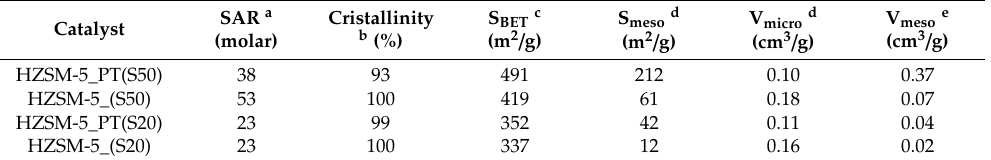
Table 1. Physicochemical and textural characterization of the parent and post-treated ZSM-5 zeolites.